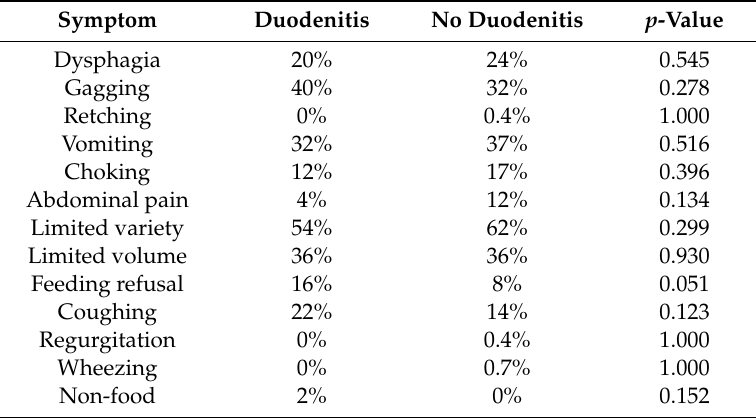
Table 6. Symptom frequencies of patients with and without